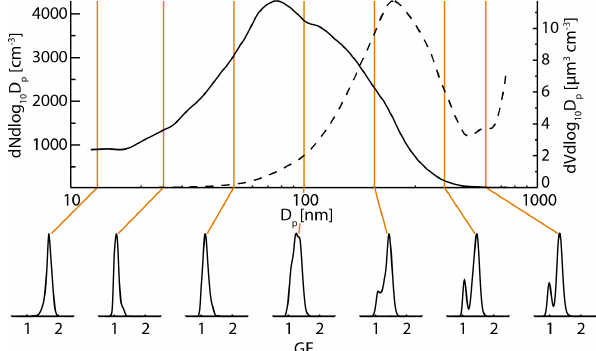
Figure A2. Example aerosol number distribution (solid line; up- per plot) and growth factor (at 90% RH) distributions (lower plots) measured by an HTDMA. The dashed line in the upper plot is the corresponding volume